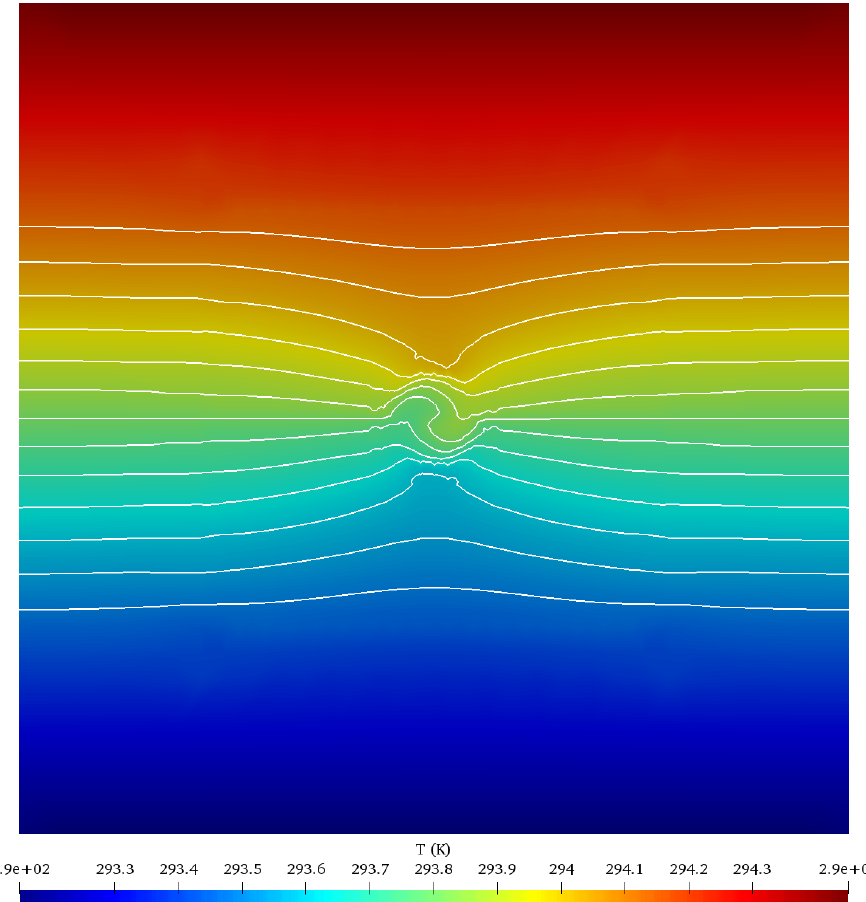
Figure 2. An x – z cross-section of the temperature field T immediately downstream of the propeller at y = 0.01 m, t = 200 s. This illustrates the mixing action of the propeller and the entrainment of − surrounding fluid into the mixed patch.